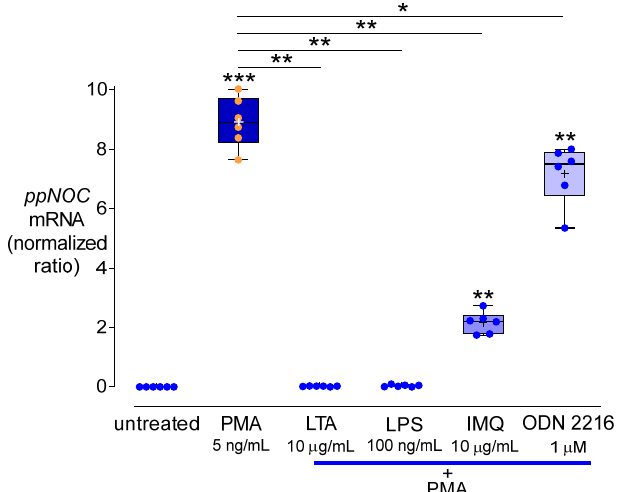
Figure 6. Effects of TLR agonists on the regulation of ppNOC mRNA by PMA in THP-1 cells. Cells were cultured with or without PMA and with or without different TLR agonists specific for TLR2 (LTA), TLR4 (LPS), TLR7 (IMQ), and TLR9 (ODN 2216) for 24 h. Boxplots with individual data points, median, IQR, and mean “+”; n = 6. Wilcoxon test with correction for multiple testing. *, p < 0.05; **, p < 0.01; ***, and p < 0.001. TLR agonists, PMA, and PMA+TLR agonists had no impact on NOP mRNA (Table 2). An increase in cell membrane NOP proteins was detected in the cells stimulated with LPS, IMQ, ODN 2216, or PMA, compared to controls (Figure 7C). No changes of cell mem ‐ brane NOP proteins were observed in the samples co ‐ stimulated with PMA+TLR agonists, compared to the PMA group (Figure 7C).